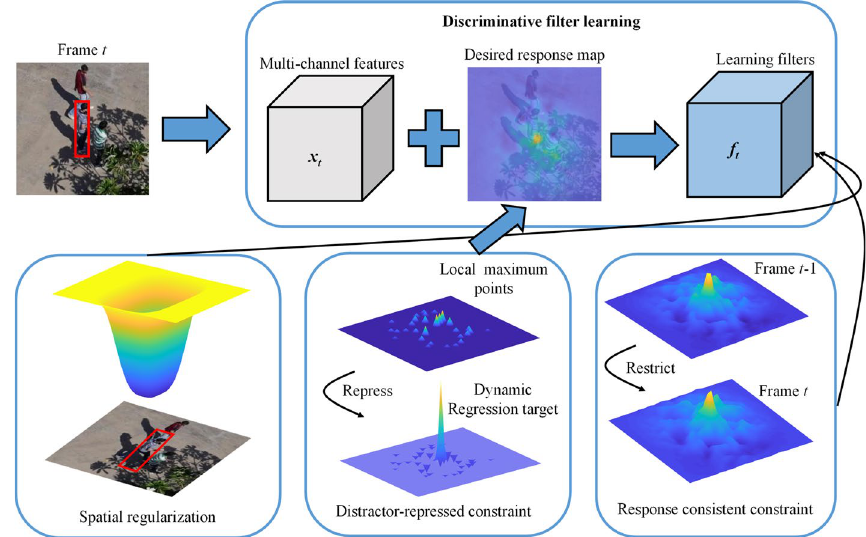
Fig. 3 Overall framework of the proposed method. The second row from left to right shows the spatial regularization, the distractor-repressed constraint, and the response-consistent constraint. In the discriminative filter learning, they are incorporated to constrain the current correlation